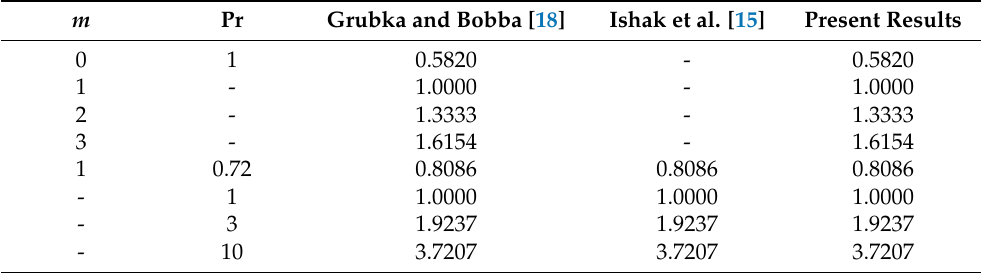
Table 3. Values of − θ (cid:48) ( 0 ) under different values of m and Pr when ϕ hnf = S = M = R = 0 and λ = 1 (stretching sheet).